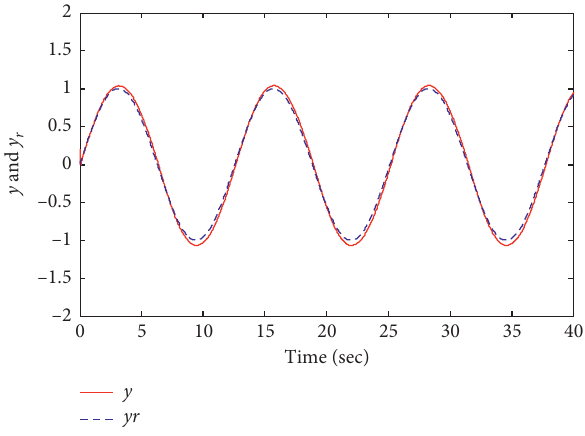
Figure 1: Output y and desired trajectory y